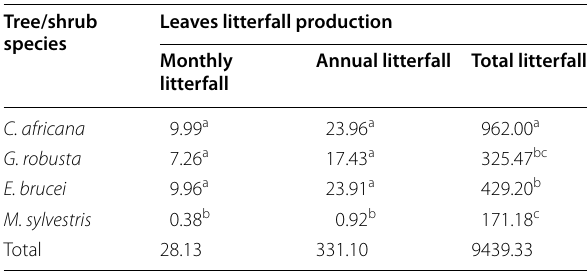
Different superscript letters in a column represent significant differences between species (P < 0.05) as determined by the Fisher’s Protected LSD. Source: Survey